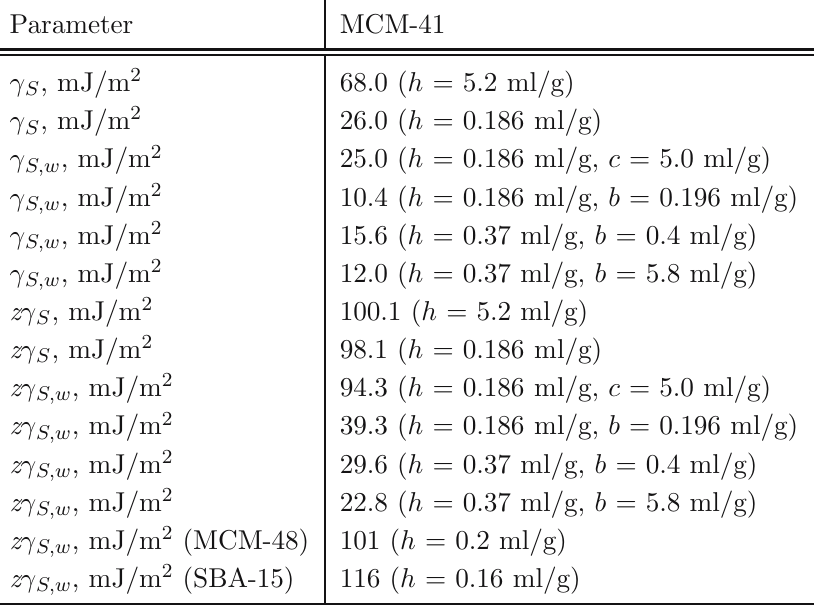
Table 2 Energetic characteristics of interfacial water adsorbed individually or in mixture with benzene or chloroform- d onto MCM-41 (sample 2), MCM-48 and